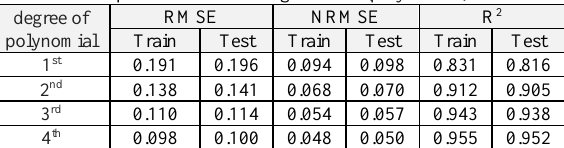
Table 2: Estimate accuracy of Lake water level model by using of time, balance model using time, monthly average of rainfall,